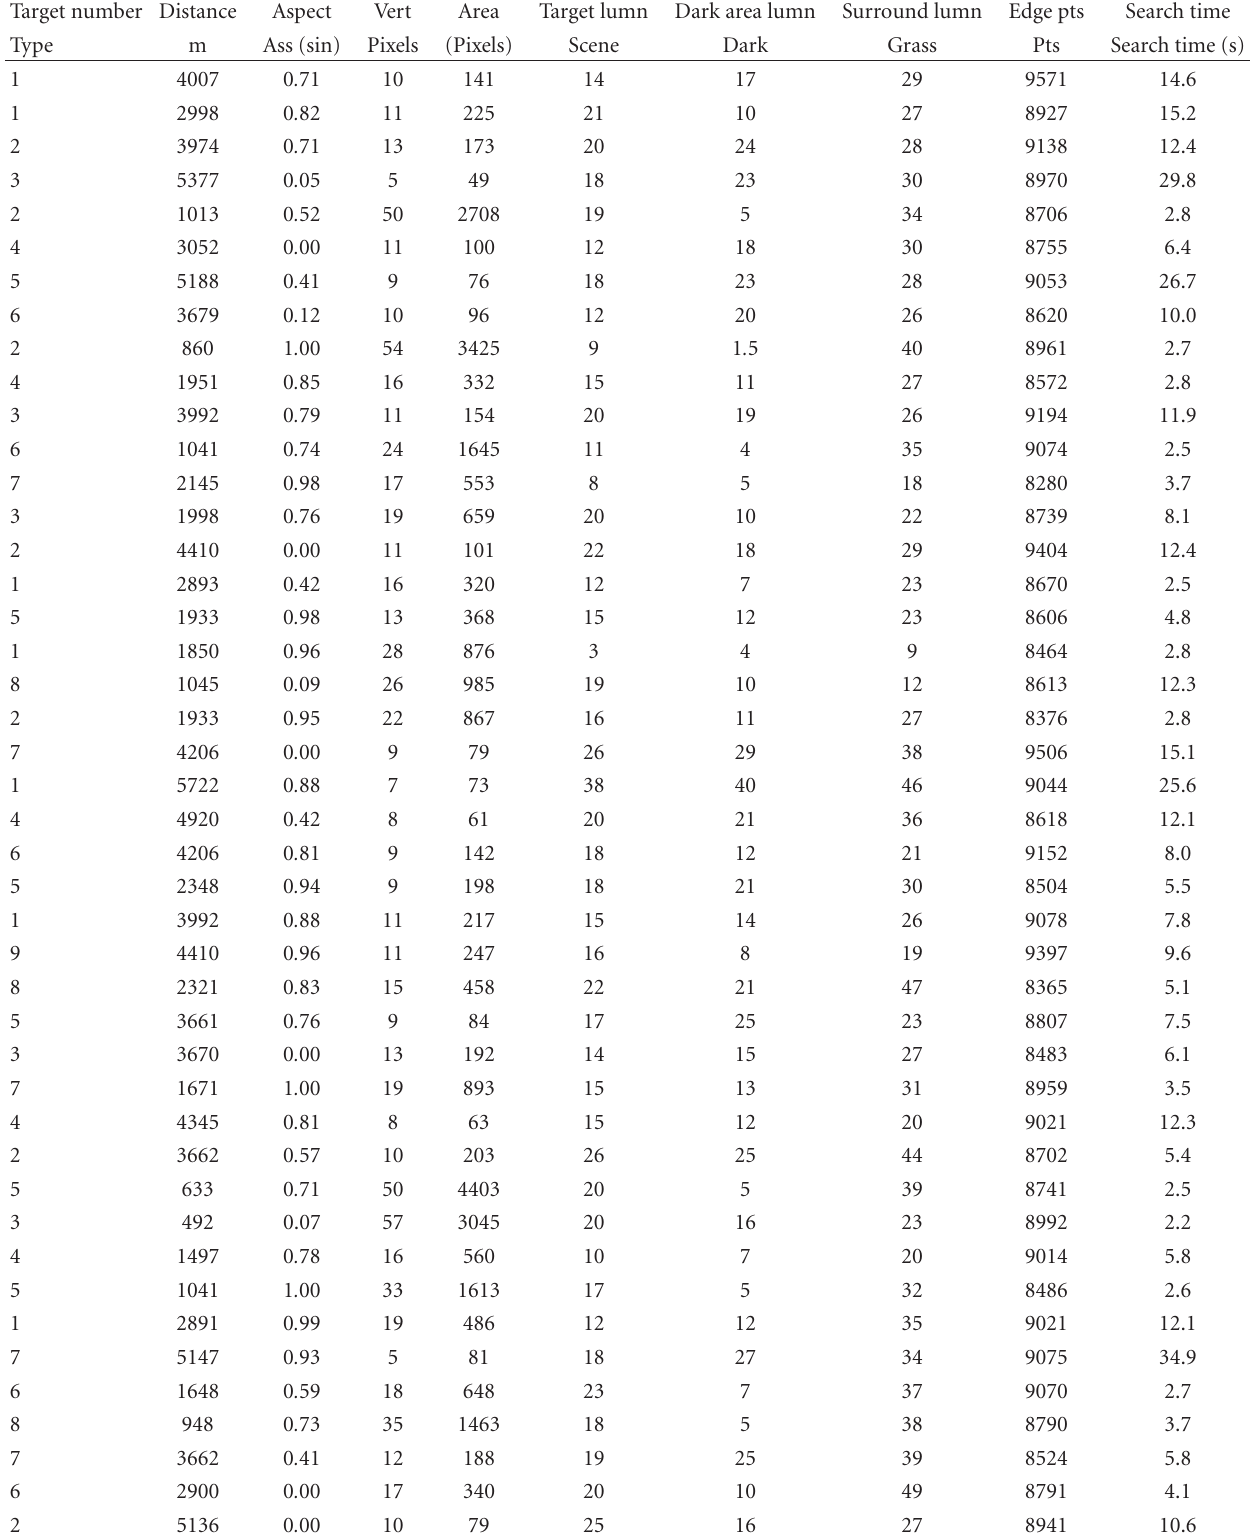
Table 3: Data reproduced from